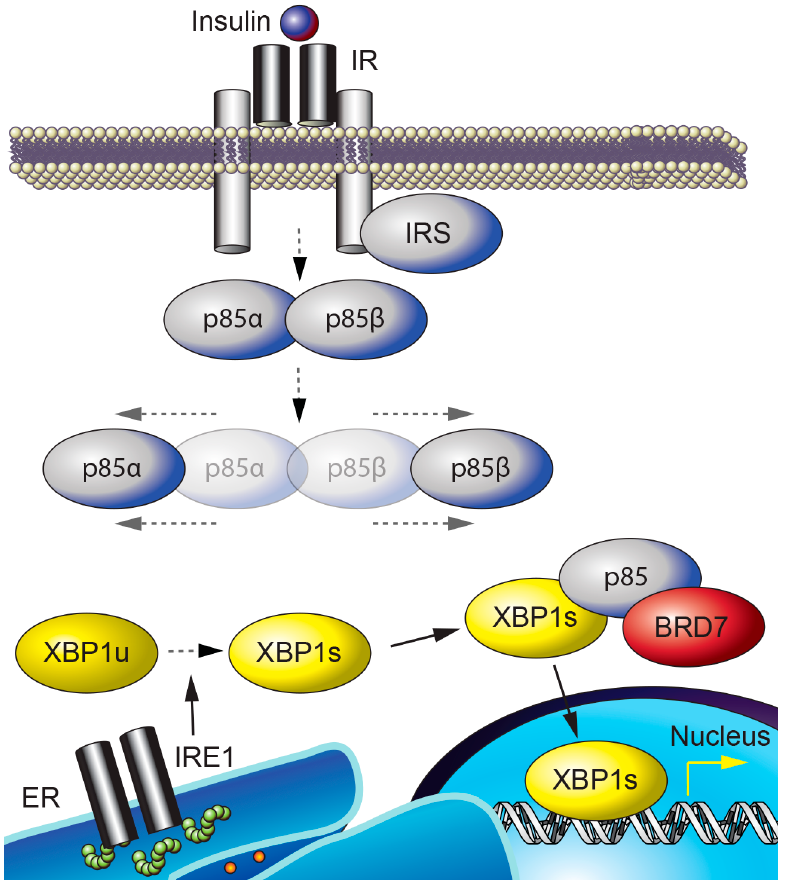
Figure 2. BRD7 and ER homeostasis. p85 α and p85 β form a heterodimer that is dissociated by insulin stimulation. IRE1 is activated by autophosphorylation upon ER stress and cleaves the unspliced form of XBP1 (XBP1u), resulting in XBP1s. BRD7, p85, and XBP1s interact to form a complex that is required for the nuclear translocation of XBP1s.